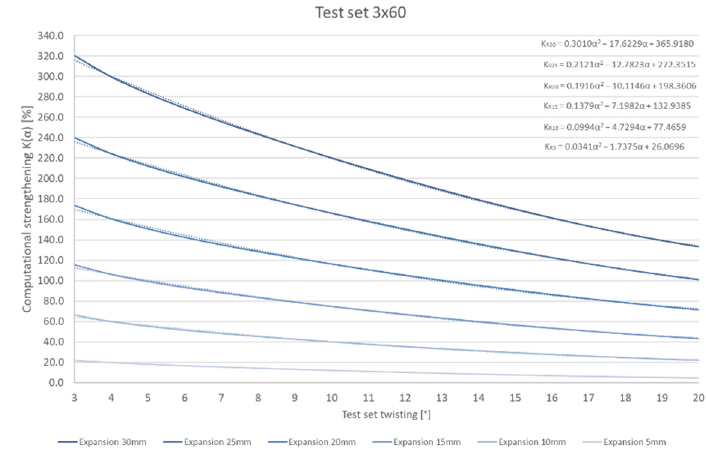
Figure 10. Variable value of the K stiffness increase index depending on the test set twisting.